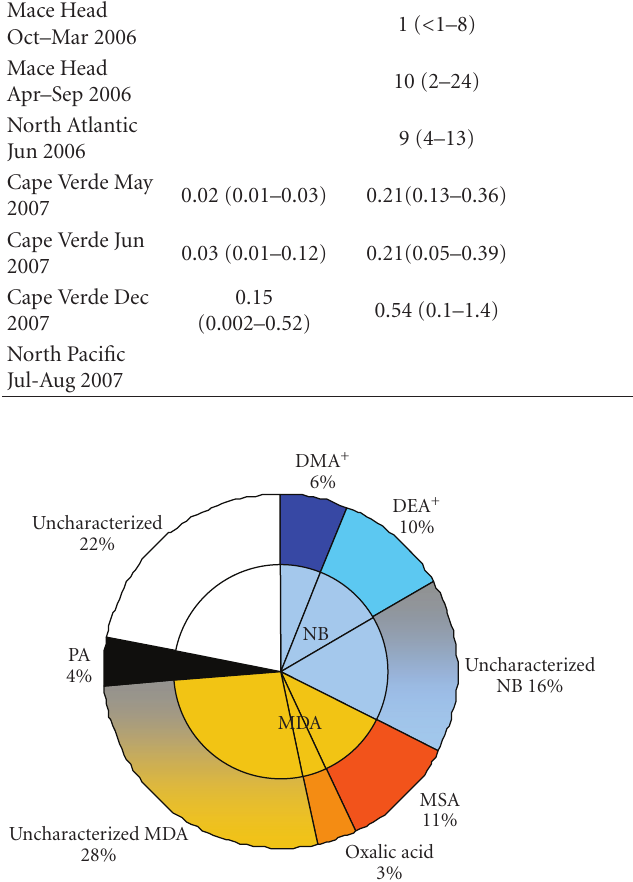
Figure 3: WSOC chemical composition representative of spring- summer conditions over the Atlantic Ocean, obtained by combining HPLC-TOC and IC (see text for more details). Percentages indicate the contribution of each compound or chemical macroclass in terms of